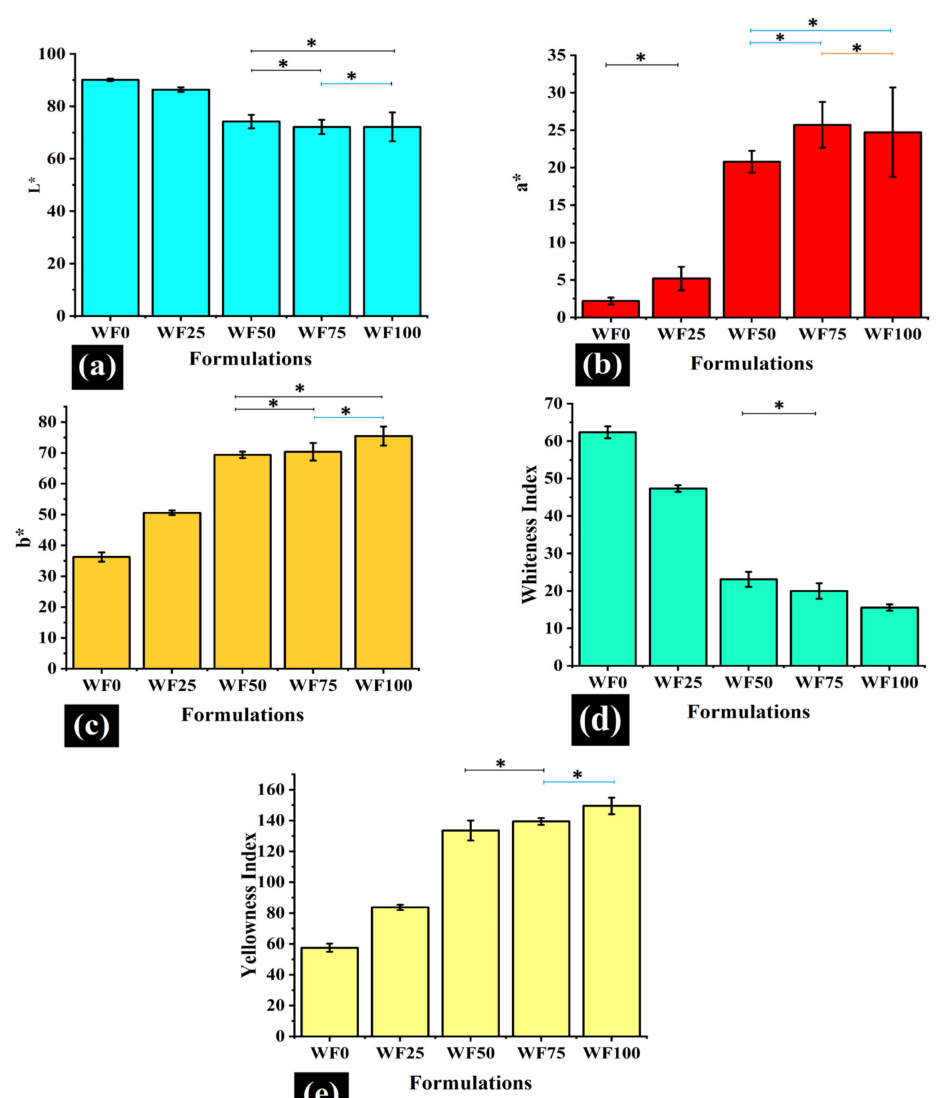
Figure 3. The colorimetric analysis is illustrated in bar graphs. ( a ) L* values of the different formu- lations. ( b ) a* values of the formulations. ( c) b* values of the formulations. ( d ) Whiteness index of samples. ( e ) Yellowness index of the samples. (Formulations with * sign have similar values; p >